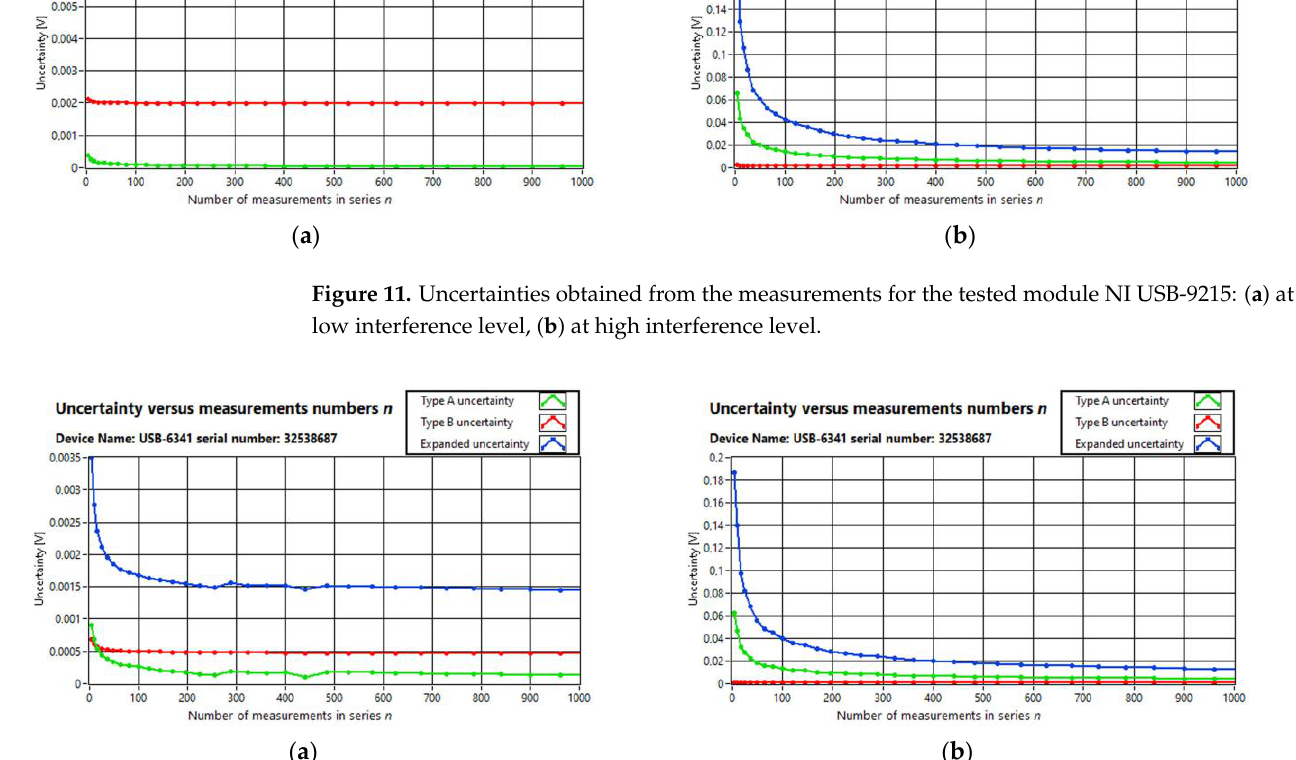
Figure 12. Uncertainties obtained from the measurements for the tested module NI USB-6341: ( a ) at low interference level, ( b ) at high interference level.